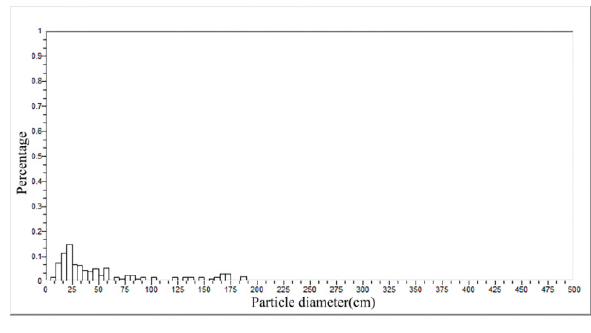
Table 5. The data ranges of parameters corresponding to membership degrees.